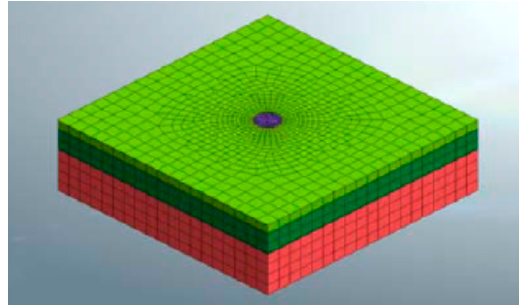
Figure 15. Numerical model of suction pile.